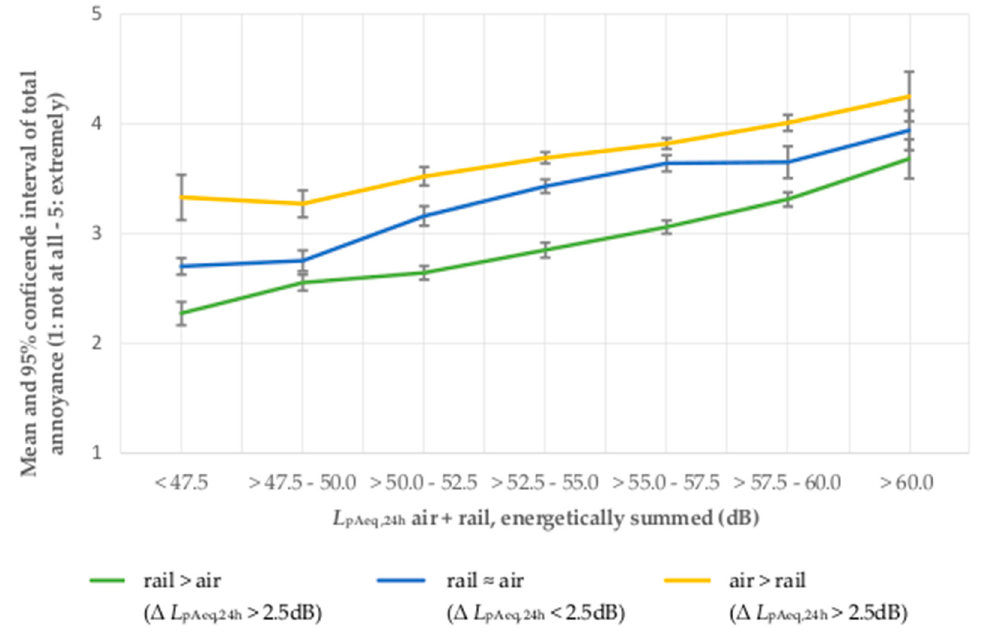
Figure 6. Total noise annoyance by aircraft and railway noise in association with the sound level dominance of the energetically summed 24-h average sound pressure level.